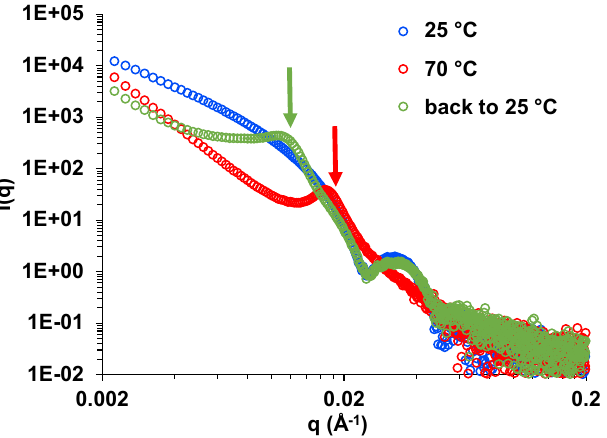
Figure 5. SAXS intensity (I(q)) versus scattering vector (q) for PDMAm 36 - b -PCMAm 360 ( Sample 7 ) in water at 1 wt%, at 25 °C (in blue), 70 °C (in red) and back to 25 °C (in green). The arrows designate d , the reciprocal length corresponding to the inter-vesicle distance.